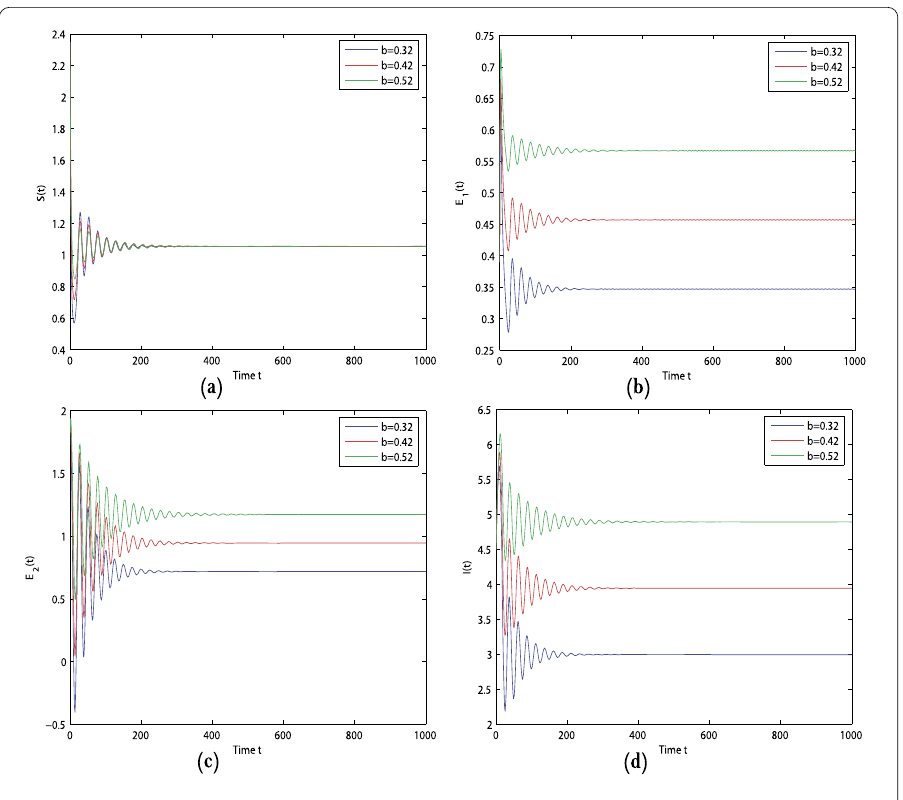
Figure 9 Time plots of S , E 1 , E 2 and I for different b at τ 2 = 6.25 < τ 20 when τ 1 = 0. Rest of the parameters are taken as given in the text